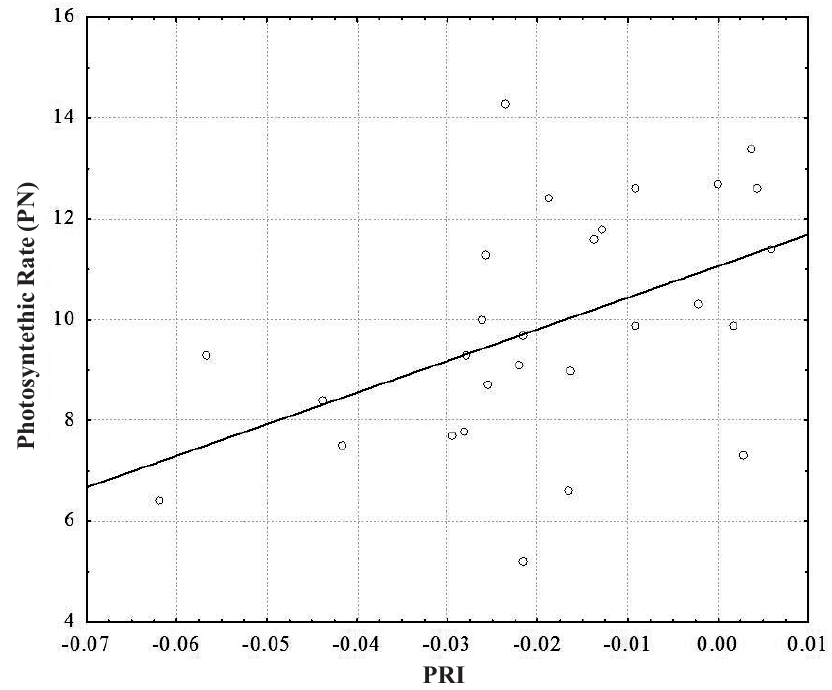
Figure 2. Significant, positive linear correlation observed on 9 March 2006 between the photosynthetic rate and the PRI values of potted grapevines receiving 20, 50, 70% and optimal (100%) irrigation (PRI:PN: R 2 =0.2286; P =0.0101 ).